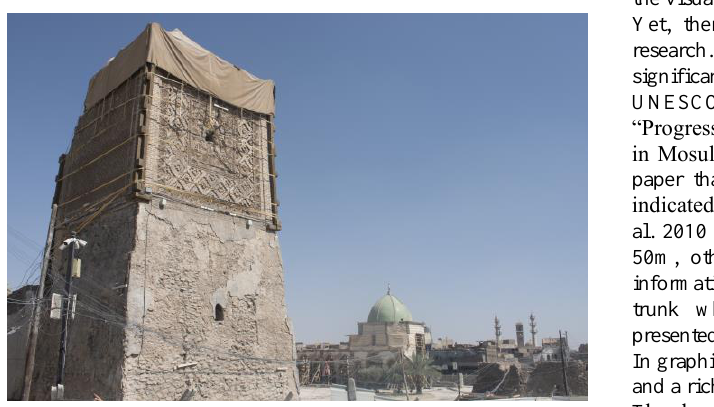
Figure 2. Remains of Al-Nuri Mosque and Al-Hadba’